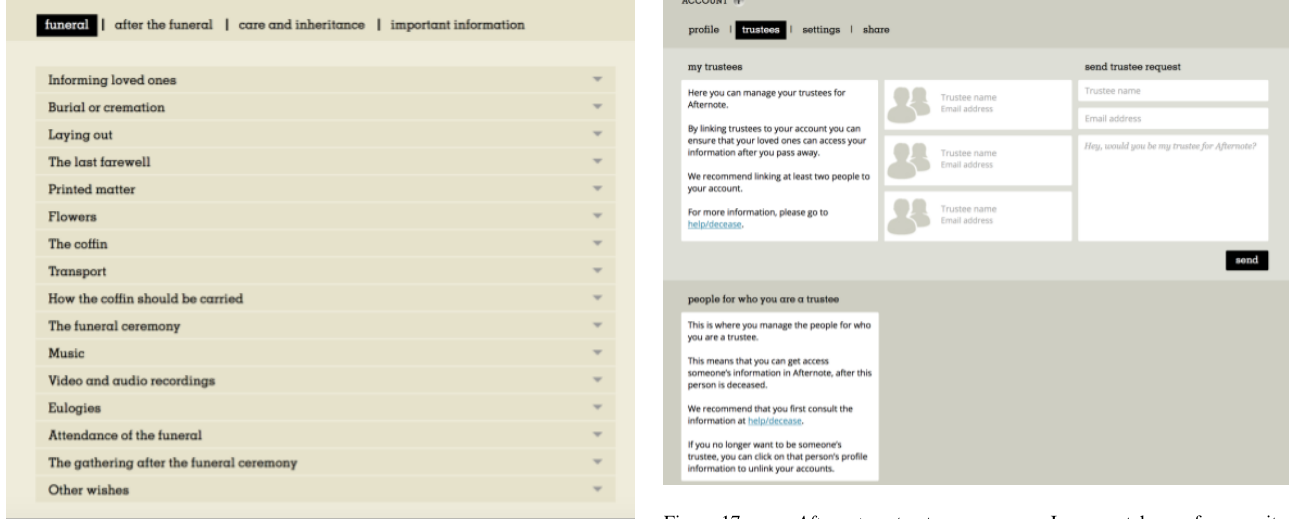
Fig. 17. Afternote trustees page. Image taken from site: